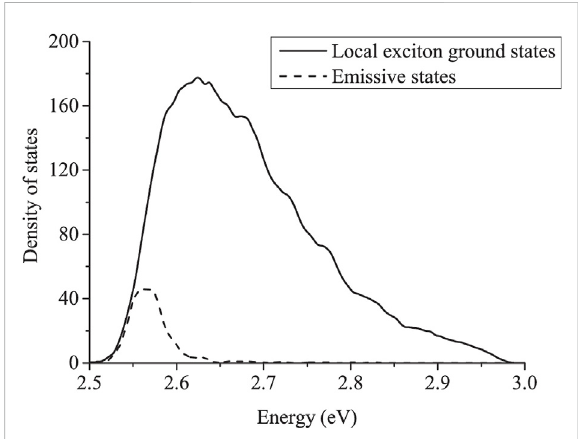
FIGURE 12 The density of states for absorbing LEGSs (solid line) and emitting trap states (dashed line) for an ensemble of PPV chains, with a Gaussian distribution of ϕ 0 and ϕ , as described in the main (cid:2) 5 0 , and σ ϕ = 5 ° . Reproduced from text. 〈 ϕ 0 〉 = 10 ° , σ ϕ 0 J. Chem. Phys. 141, 164103 (2014) with the permission of